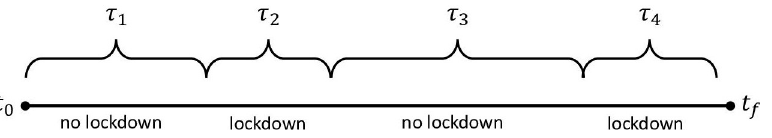
Fig 15. Lockdowns (discrete policies) parametrized with continuous time. In this example there are two lockdowns and two periods of freedom. The algorithm finds the optimal distribution and minimises the total time τ 2 + τ 4 in